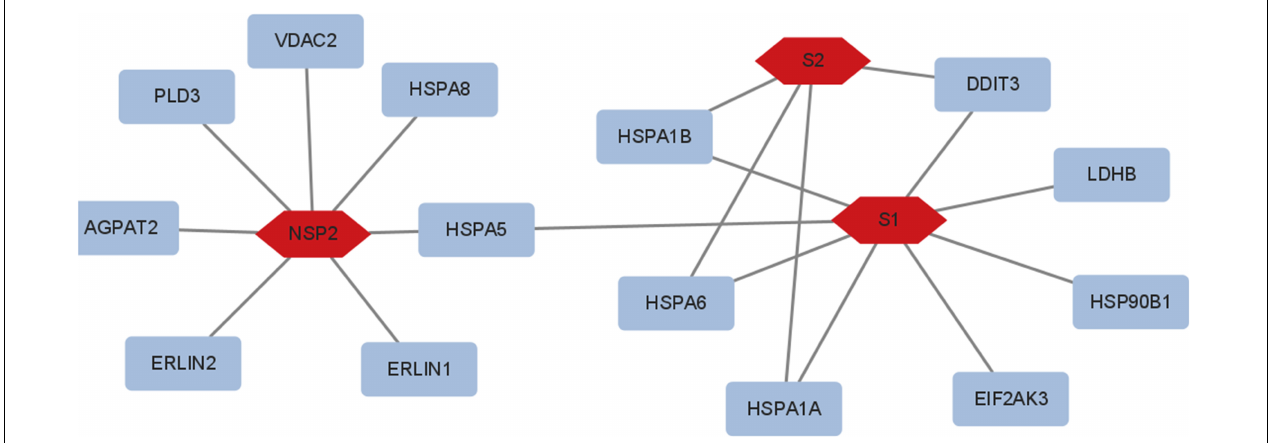
FIGURE 6 | The viral proteins involved in metabolic reprogramming. S1 regulated HSPA1A, HSPA6, HSPA1B, DDIT3, LDHB, HSP90B1, and EIF2AK3; S2 regulated HSPA1B, HSPA1A, HSPA6, and DDIT3; Nsp2 regulated PLD3, VDAC2, HSPA8, HSPA5, ERLIN1, ERLIN2, and AGPAT2. N, Nsp15, and Nsp16 did not modify metabolic